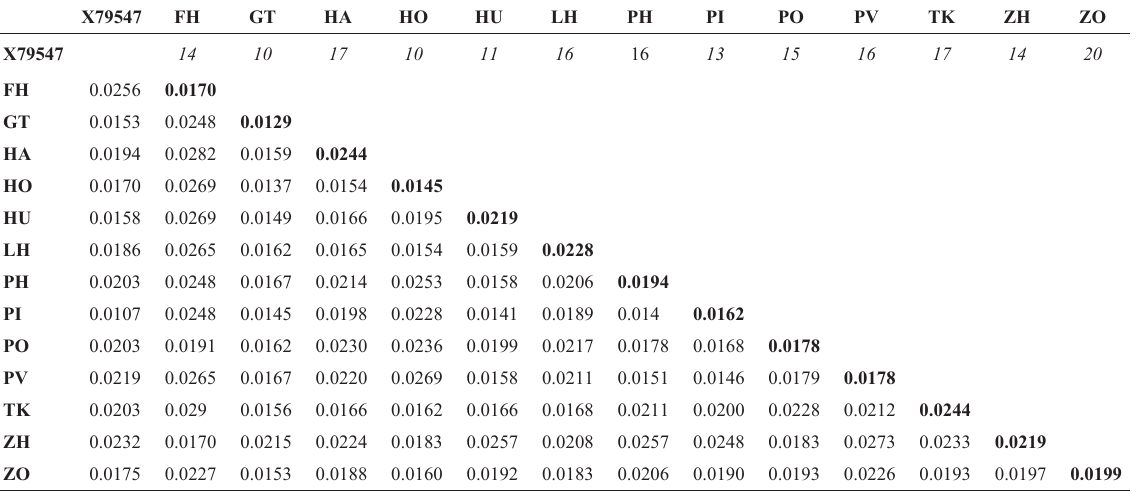
Table 2 - Distances calculated by Kimura two-parameter method. Distances within the groups are given in bold. Nucleotide differences between reference and horse groups are given in italic. See text for